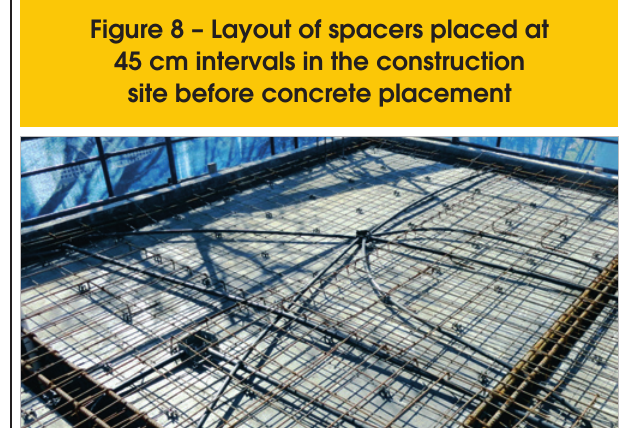
Figure 8 – Layout of spacers placed